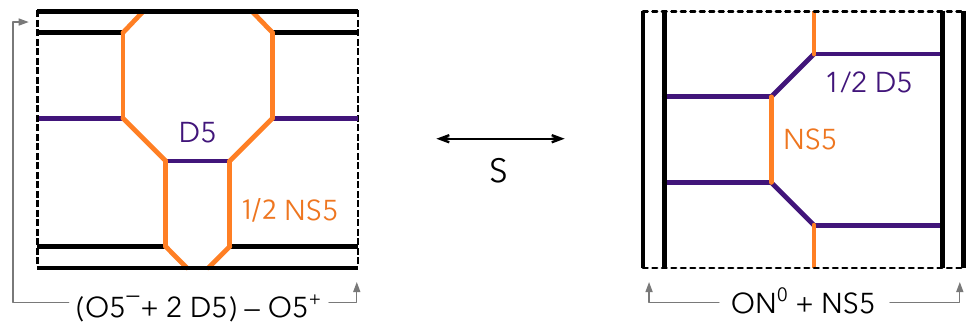
Figure 5. Duality between the generic 5-brane con(cid:12)gurations at N = 1 and n =